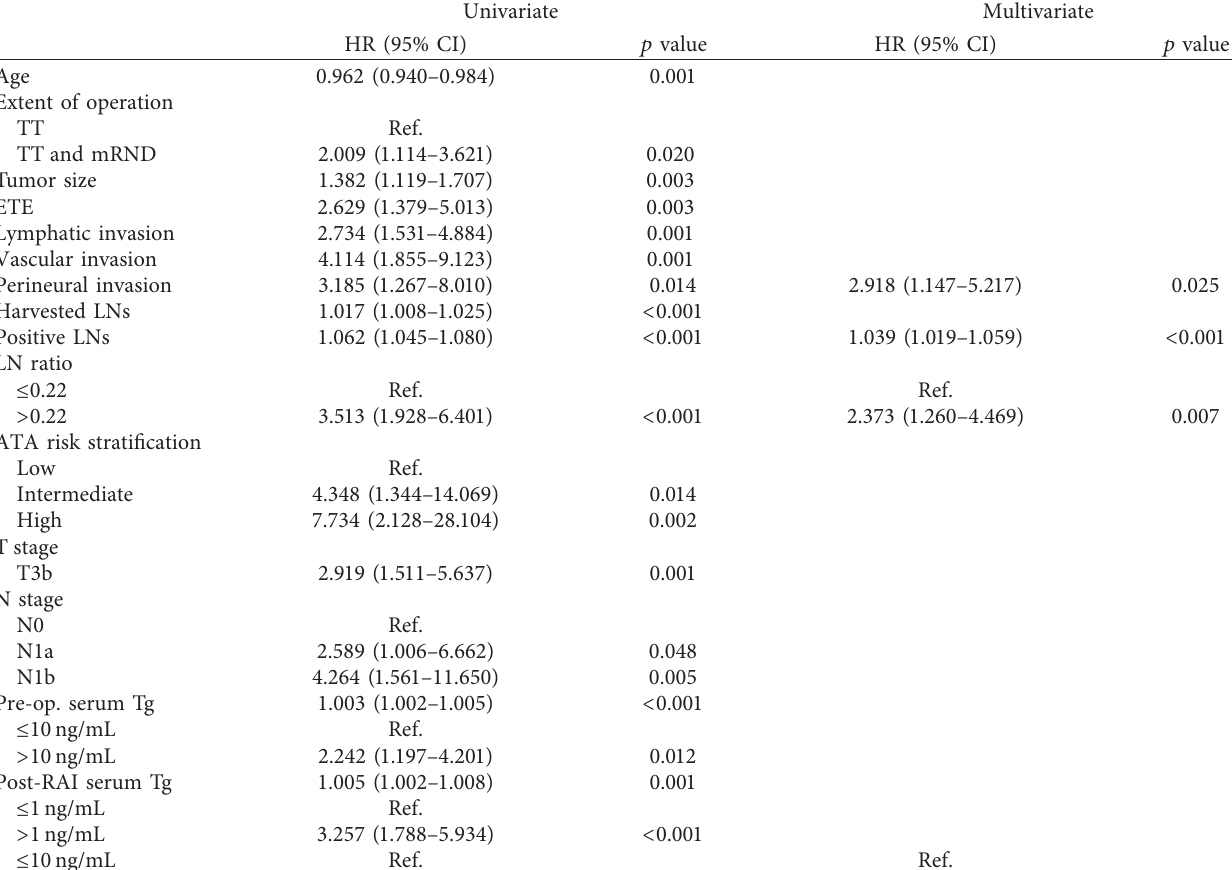
Table 3: Univariate and multivariate analyses of recurrence risk factors before propensity score